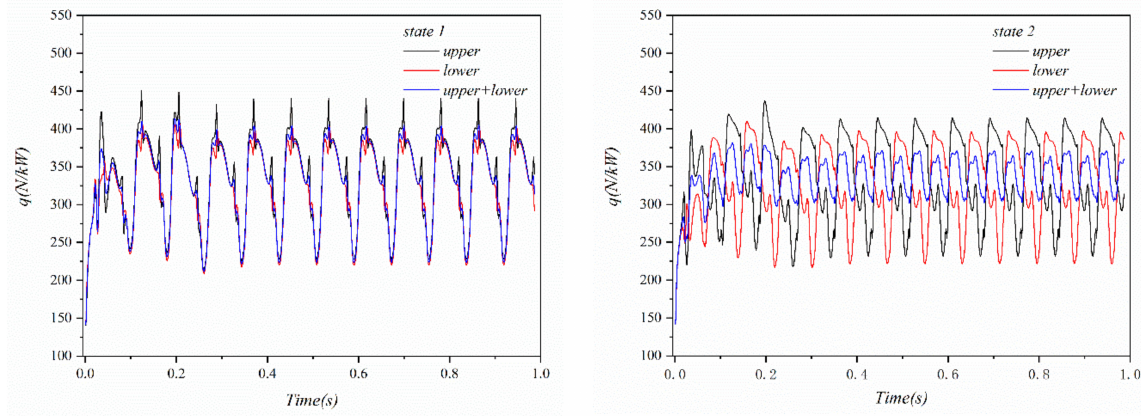
Figure 18. The isolated rotor q of the upper and lower rotors in forward